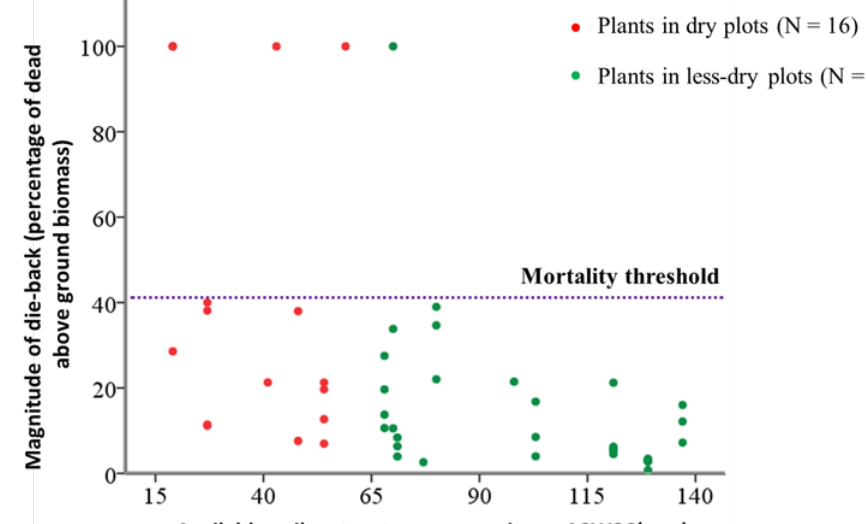
Figure 3. Mortality threshold of crown dieback, expressed by above ground dead biomass percentage for the young beeches in dry and less dry plots, expressed by available soil water storage capacity (ASWSC in millimeters). The figure shows the crown dieback threshold at